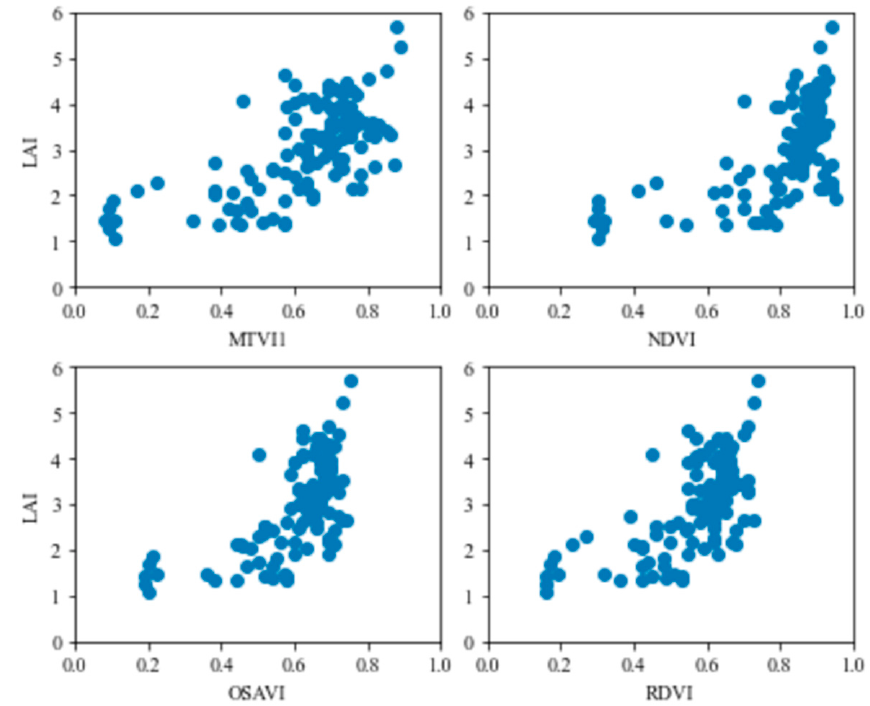
Figure 3. Leaf area index (LAI) in association with four different vegetation indices of interest for wheat. MTVI1, NDVI, OSDVI, and RDVI represent the modified triangular vegetation index 1, normalised difference vegetation index, optimised soil-adjusted vegetation index, and re-normalised difference vegetation index, respectively.